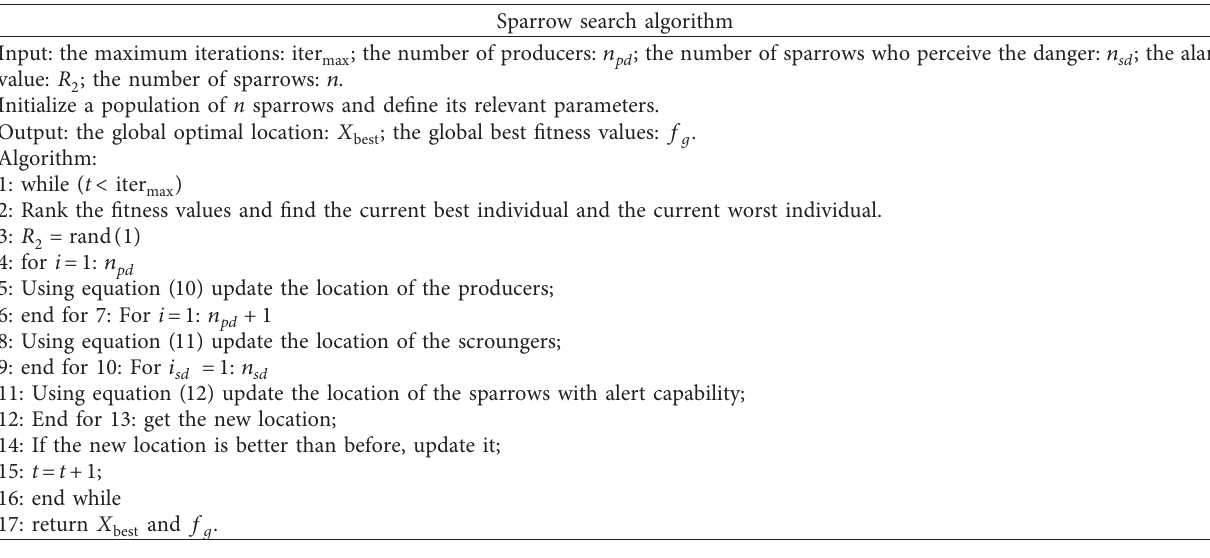
Table 1: The basic architecture of SSA. Sparrow search